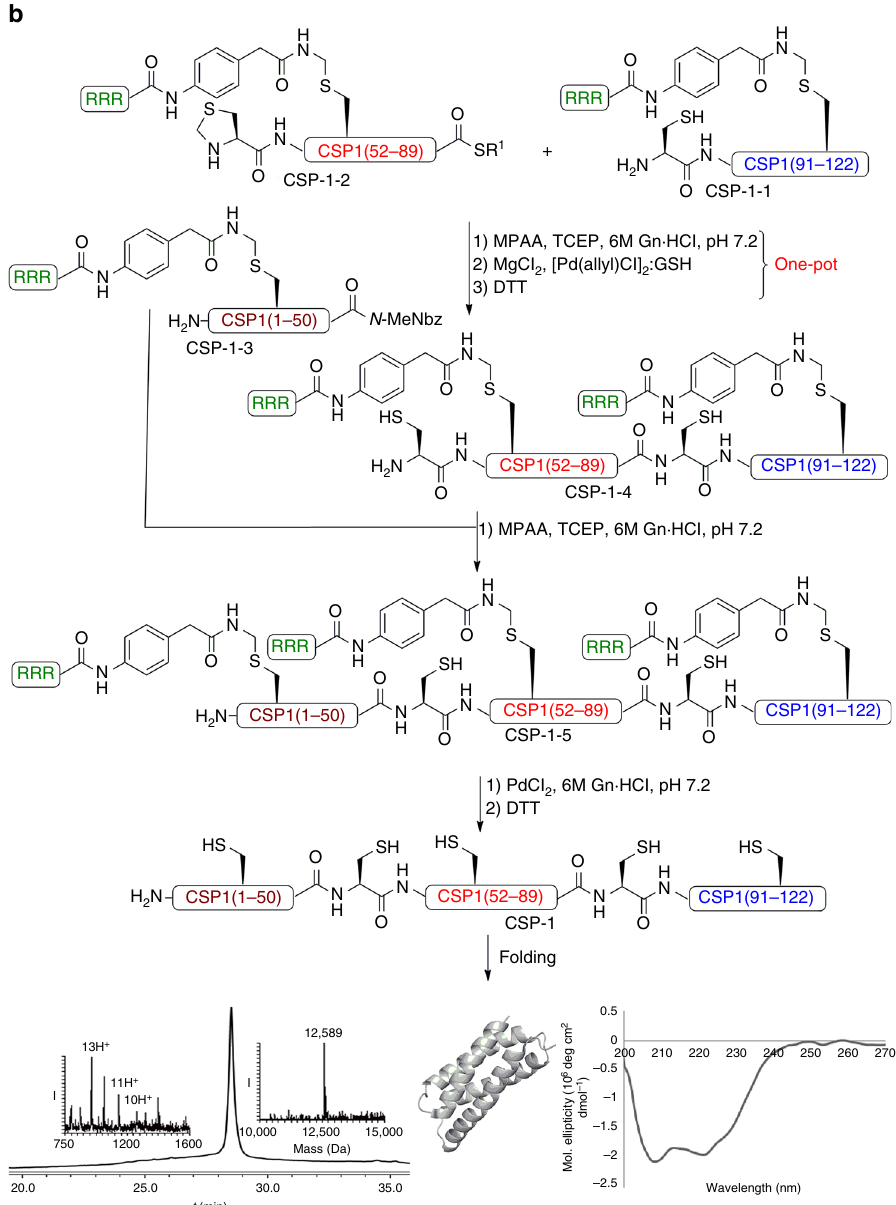
Fig. 4 Total chemical synthesis of CSP-1. a The CSP-1 sequence where the two-ligation sites are underlined. b Synthesis of CSP-1, analytical HPLC and mass traces for puri fi ed CSP-1 with the observed mass 12589 ± 1.1 Da, calcd 12590 Da (average isotopes) and CD spectrum. R 1 : 3-Mercaptopropionate, N - MeNbz: N -acyl- N ′